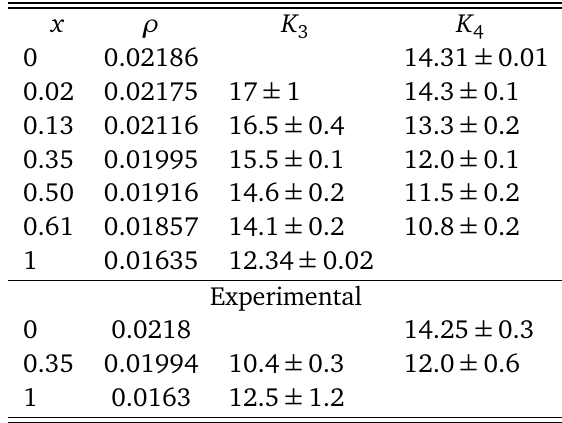
Table 2: Relative fraction x of 3 He in 4 He, at the given densities ρ , along with estimated values for the kinetic energy per atom of 3 He, K concentration. Energies are shown in units of K; numerical densities in Å − 3 . Experi- mental data for pure 4 He, for a concentration x = 0.35 of 3 He atoms in the mixture and for pure 3 He are, in this order, from Refs. [ 88, 93, 94 ] and obtained at 0.045, 1.96, and 0.5 K, respectively. Simulations for concentration x = 1 were made with 114 bodies; in all others the total number of atoms was